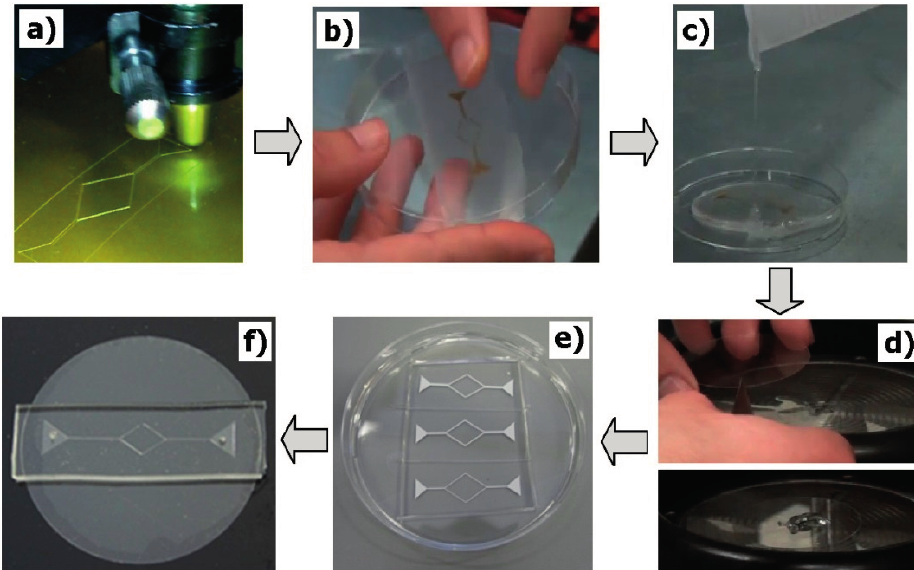
Figure 3. Main steps of the fabrication procedure: ( a ) Cutting the CAD geometries in the vinyl paper by means of a cutting plotter; ( b ) transfer the mold to the petri dish using an adhesive; ( c ) pouring the polymer PDMS over the mold to obtain the microchannel; ( d ) spin coating a slide glass with PDMS; ( e ) remove the cured PDMS microchannel